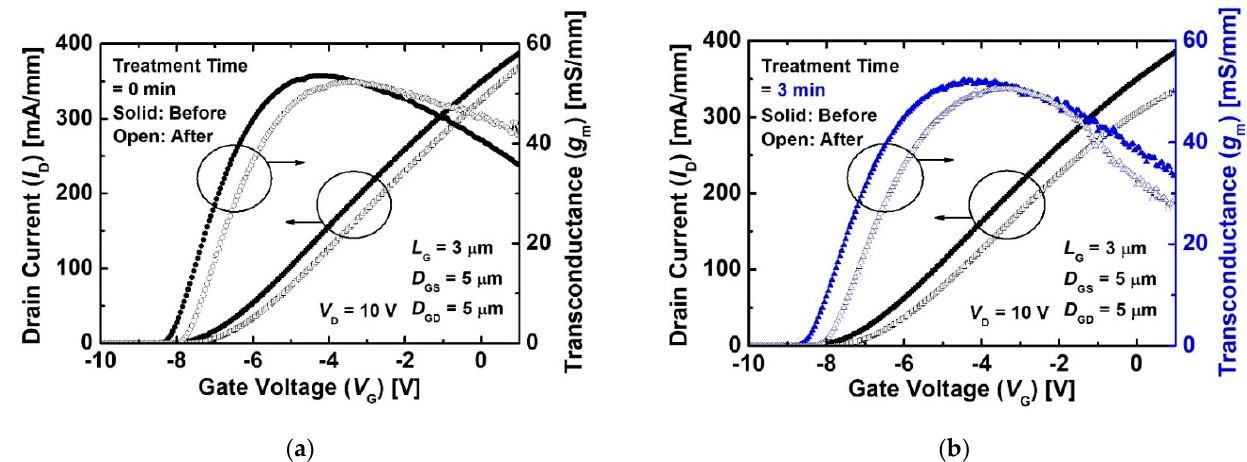
Figure 2. I D and g m characteristics as a function of V G before and after 5 MeV proton irradiation of the MIS ‐ HEMTs ( a ) without treatment and ( b ) with treatment for 3 min at a V D of 10 V. The L G , D GS , and D GD of the device were 3, 5, and 5 μ m, respectively.